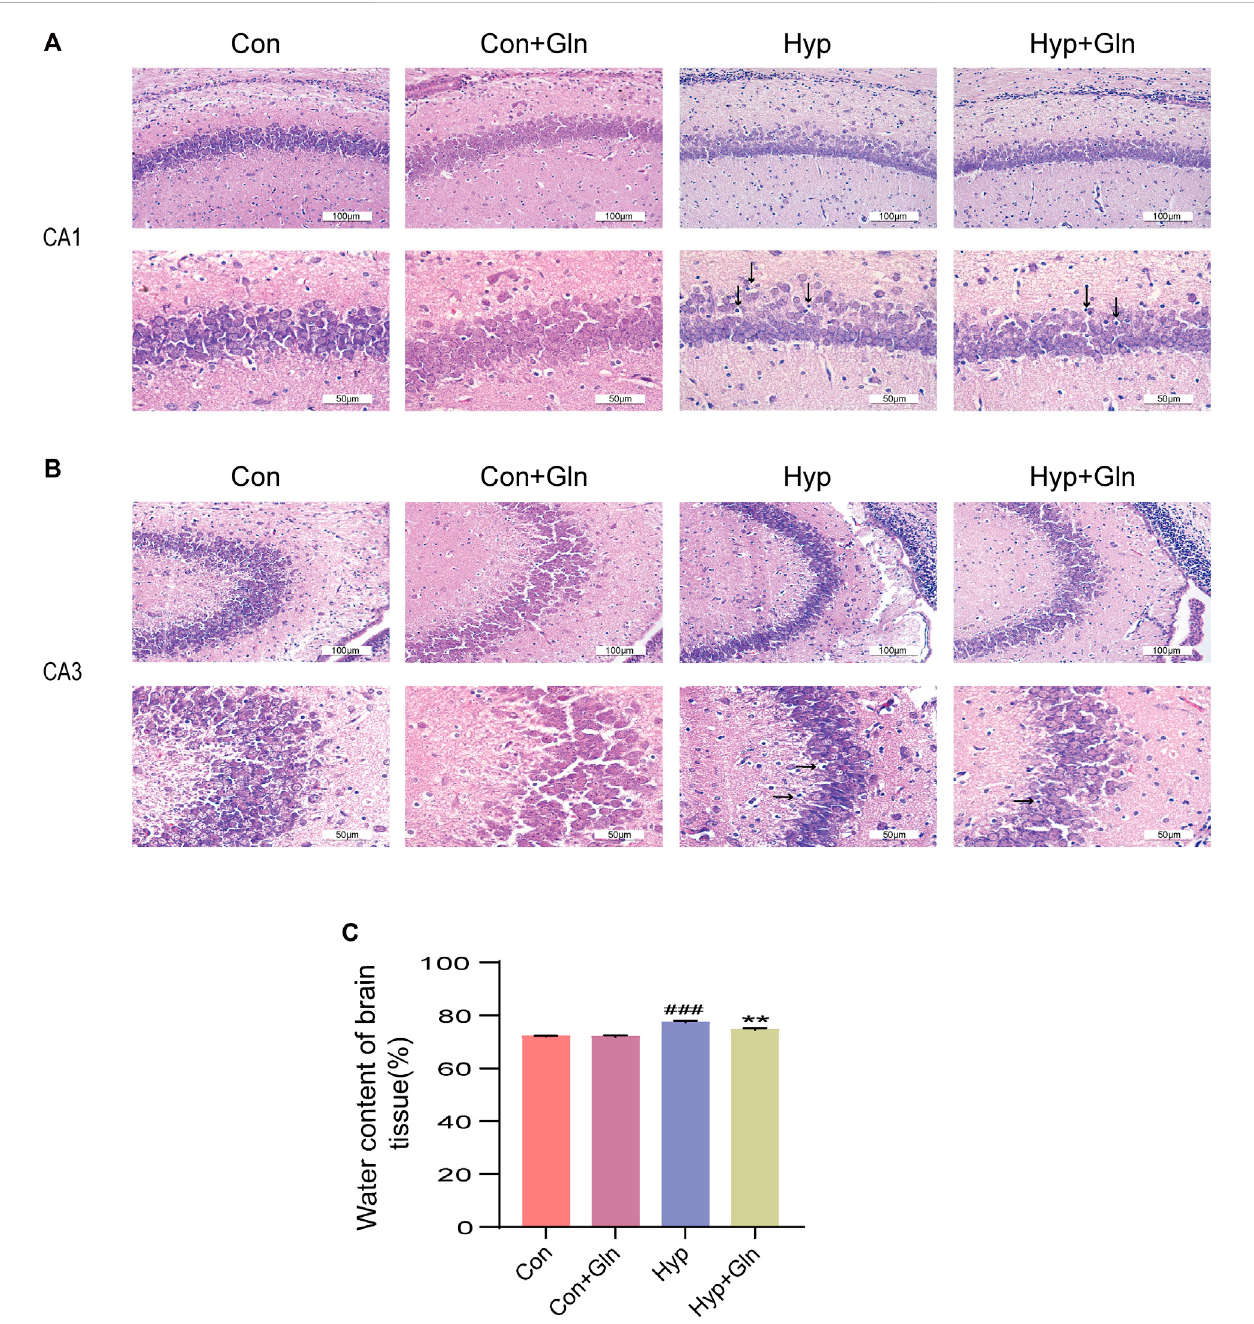
FIGURE 2 Gln ameliorates hyperoxia-induced cerebral edema and brain tissue damage. (A) Morphological changes of CA1 area of hippocampus in each group. Scale bar = 100 µm, 50 µm (B) Morphological changes of CA3 area of hippocampus in each group. Scale bar = 100 µm, 50 µm (C) Changes of brain water contentineachgroup. Con(72.11 ± 0.12),Con+ Gln (71.94 ± 0.32), Hyp (77.41± 0.37), Hyp+ Gln (74.66± 0.29). ### p < 0.001 vs.theCon,** p < 0.01 vs. the Hyp ( n = 3). p < 0.05 was considered statistically signi fi cant. Areas of severe histopathological changes were marked by black